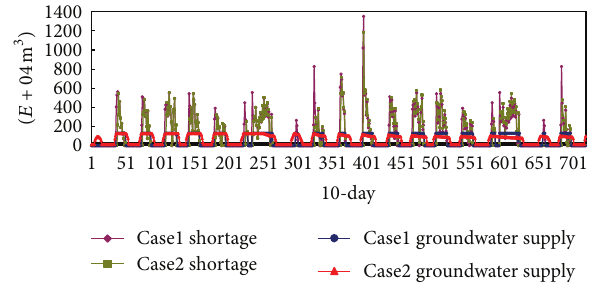
Figure 8: Comparison of supply of subsurface water and shortage between Cases 1 and